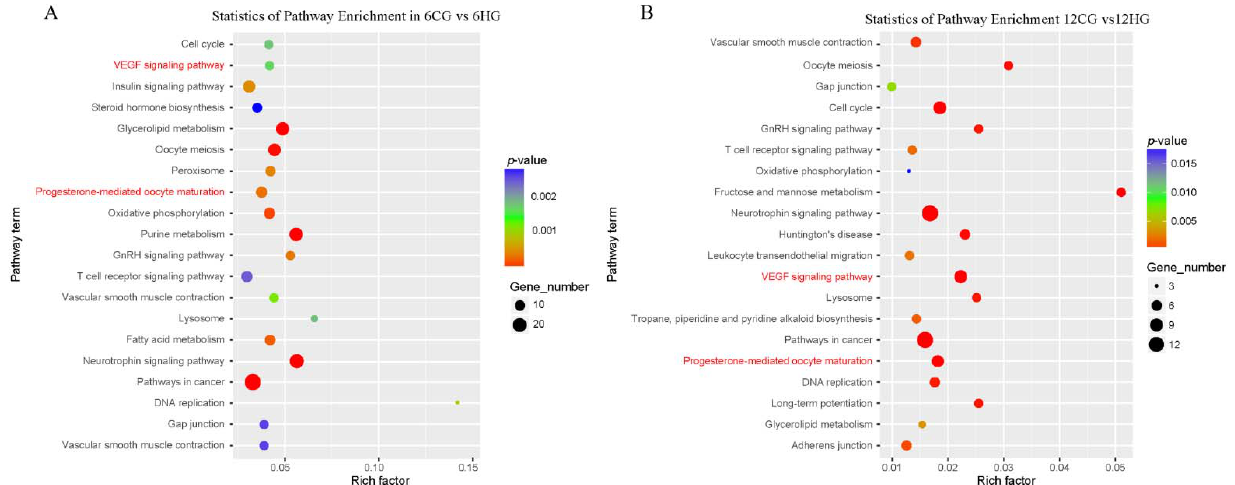
Figure 5. Analysis of enrichment pathways of miR-33 potential target gene ( A , B ). Note: KEGG subclasses enriched with target genes of miR-33, and signal pathways of potential target genes of miR-33. Circle diameter indicates quantity of potential target genes in the corresponding pathway.